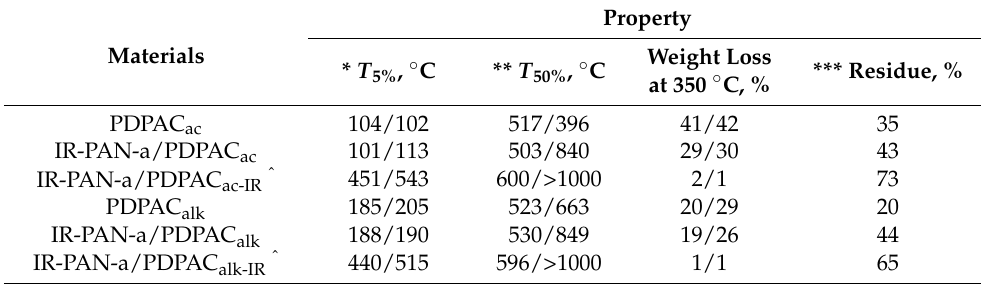
Table 2. Thermal properties of materials.